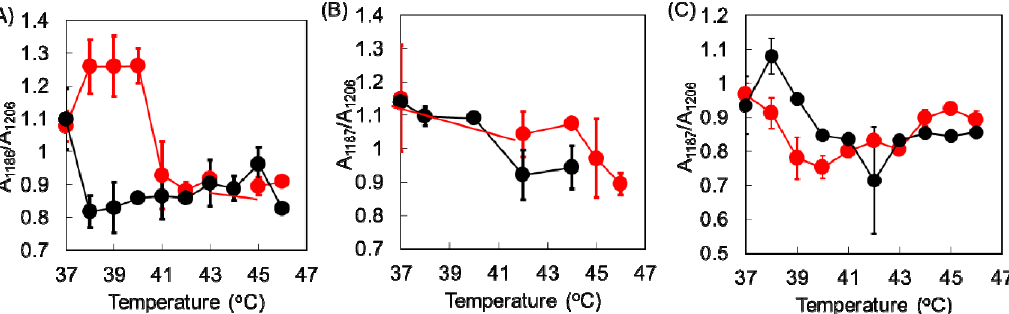
Figure 5. Ratio of amide III signals (1186 cm − 1 /1206 cm − 1 ) of collagen gels with and without AuNPs (red and black) as a function of temperature. ( A ) Cellmatrix type I-A, ( B ) Atelocell IAC, and ( C ) Cellmatrix type I-C.